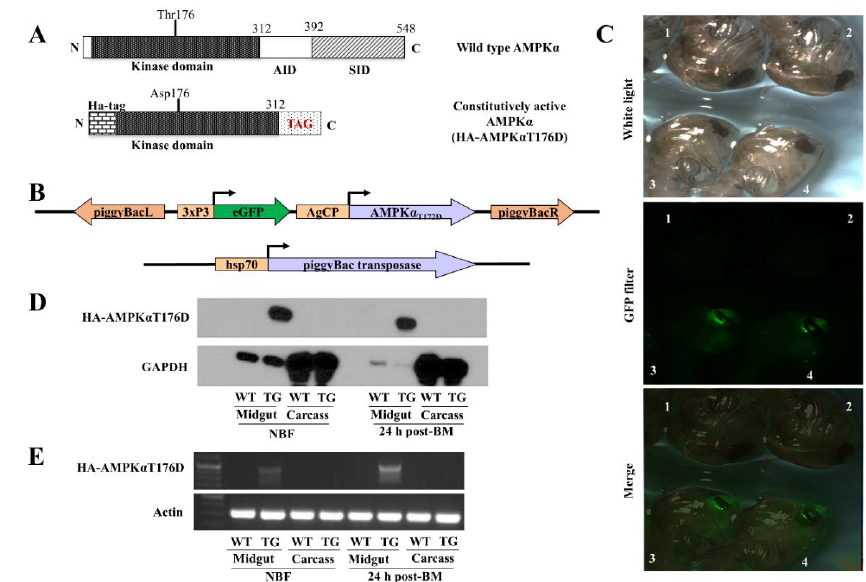
Figure 1. Generation of the HA-AMPKαT176D transgenic An. stephensi and protein and transcript expression profile of the transgene in adult females. ( A ) Full length AMPKα subunit versus constitutively active AMPKα subunit. Changes include removal of the inhibitory domains, conversion of Thr176 to Asp176 and the addition of an HA epitope. ( B ) Schematic of the construct genetically engineered into An. stephensi mosquitoes. ( C ) Comparison of transgenic (TG) and non-transgenic (NTG) siblings. Top panel: NTG (1 & 2) and TG pupae (3 and 4) under white light. Middle panel: TG and NTG under fluorescence and a GFP filter. Bottom panel: merge of top and middle panels. ( D ) Representative immunoblot of total proteins isolated from the midguts or carcasses (whole body minus midgut) of TG and NTG mosquitoes and probed with anti-HA antibody (top) or anti-GAPDH antibody (bottom) as loading control. ( E ) Total RNA was isolated from the midguts or carcasses of both TG and NTG mosquitoes and converted into cDNA. Transgene specific primers were used to amplify HA-AMPKαT176D (top). Actin -specific primers were used as positive control to verify the integrity of the cDNA (bottom). No template controls served as negative control. All transcript and protein expression studies were replicated a minimum of 3 times.